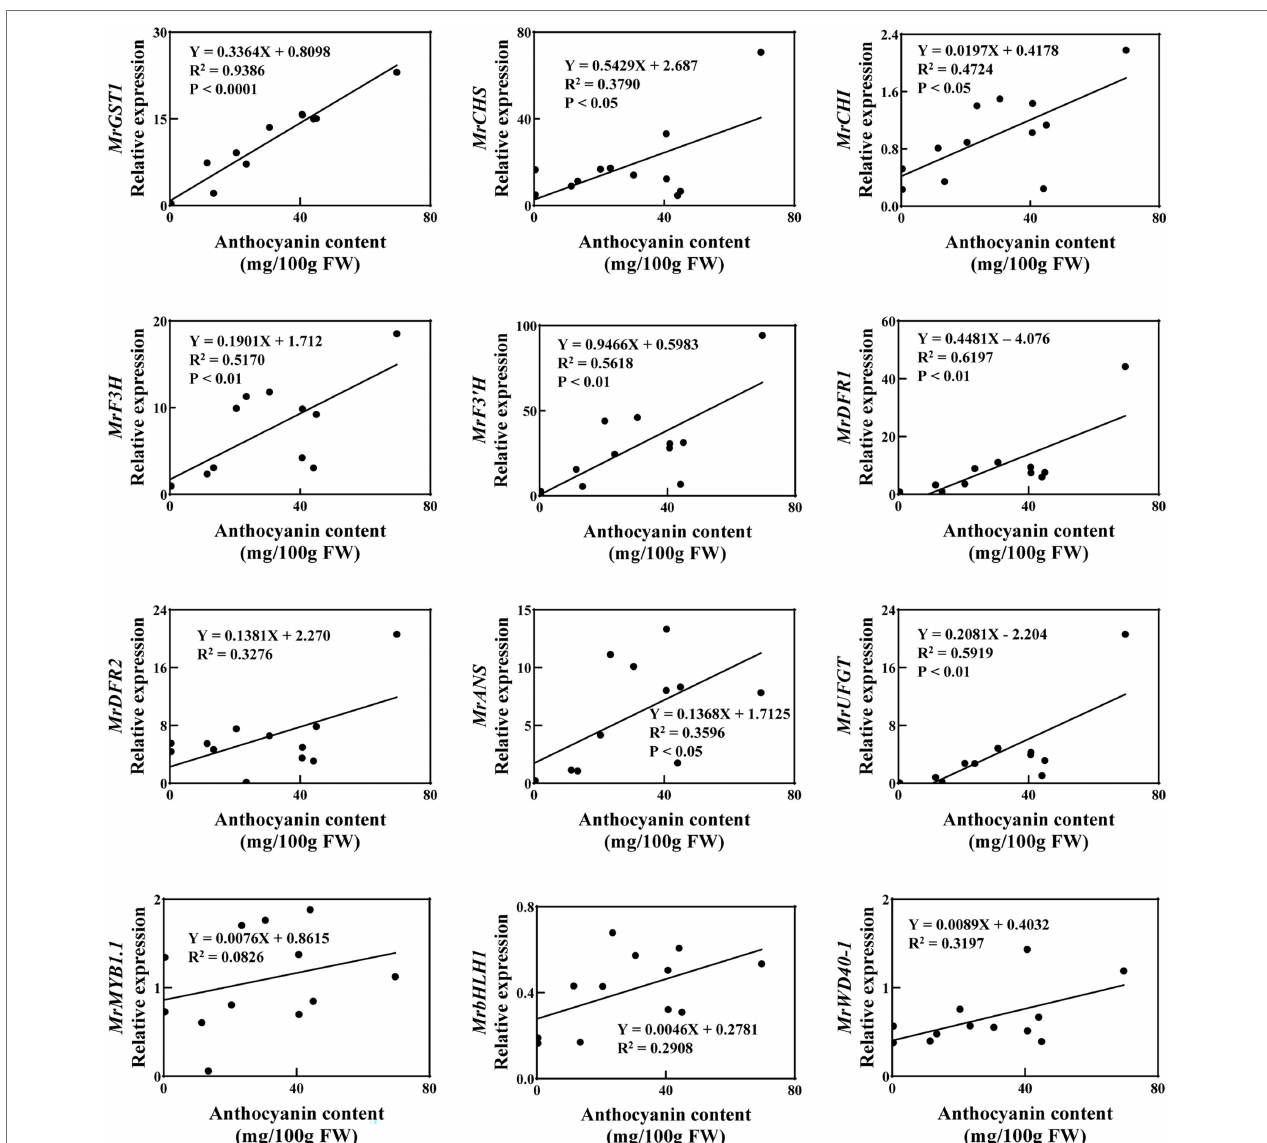
FIGURE 3 | Correlation between the anthocyanin content and expression of biosynthetic genes, transcription factors and MrGST1 of 12 Chinese bayberry cultivars fruit at 86 DAFB. Data were means (±SE) from three independent biological